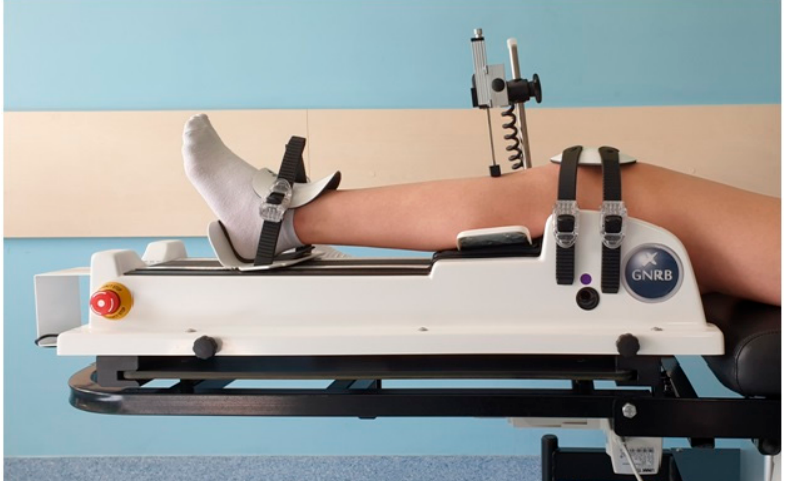
Figure 3. The patient was lying on a standard examination table in the supine position with the arms placed along the body, each knee being comparatively tested, the healthy knees are investigated first. The lower limb is placed in rigid adjustable leg support, with the knee placed at 0° of rotation. The knee should be placed so that the inferior pole of the patella corresponds to the lower border of the patellar support, the joint line is palpated and should be located between the support and the